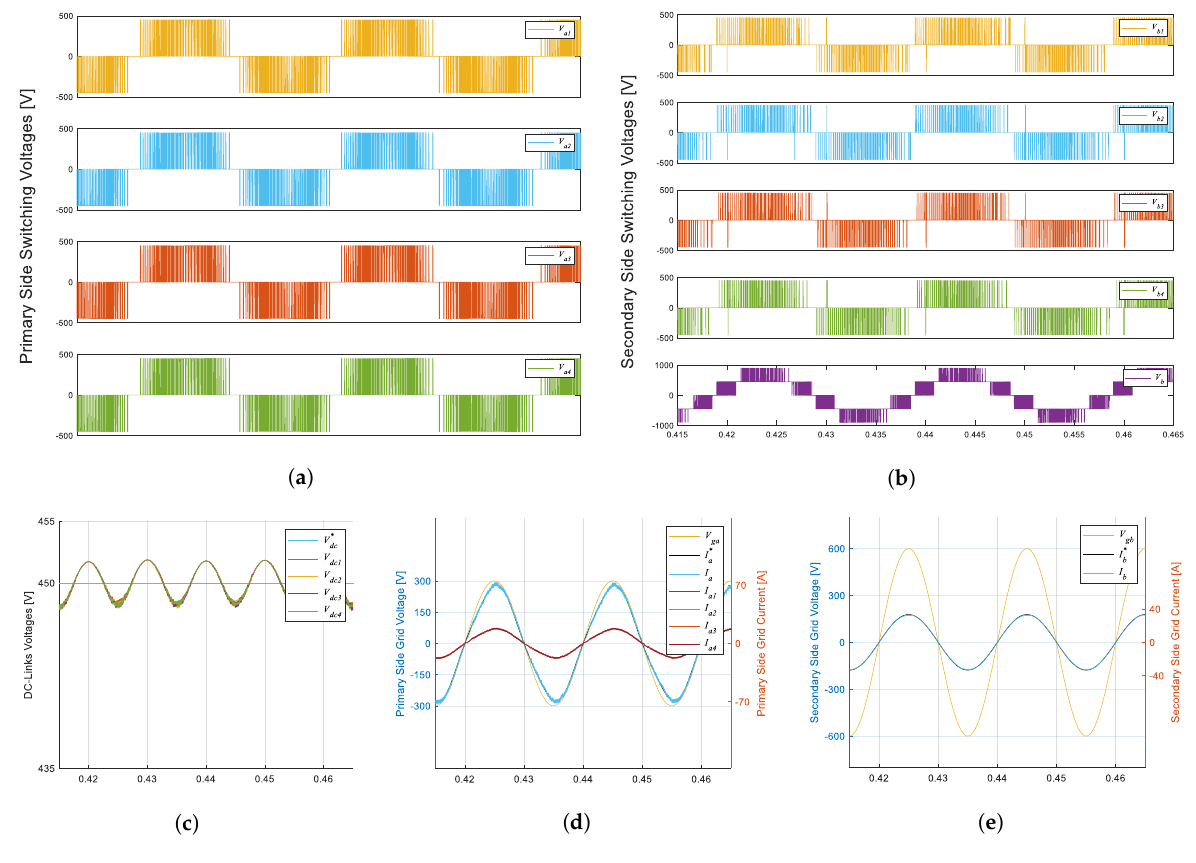
Figure 18. The 4-modules IPOS configuration simulation results: ( a ) primary side switching voltages, ( b ) secondary side switching voltages, ( c ) DC-links voltages, ( d ) primary side grid voltage and currents, ( e ) secondary side grid voltage and